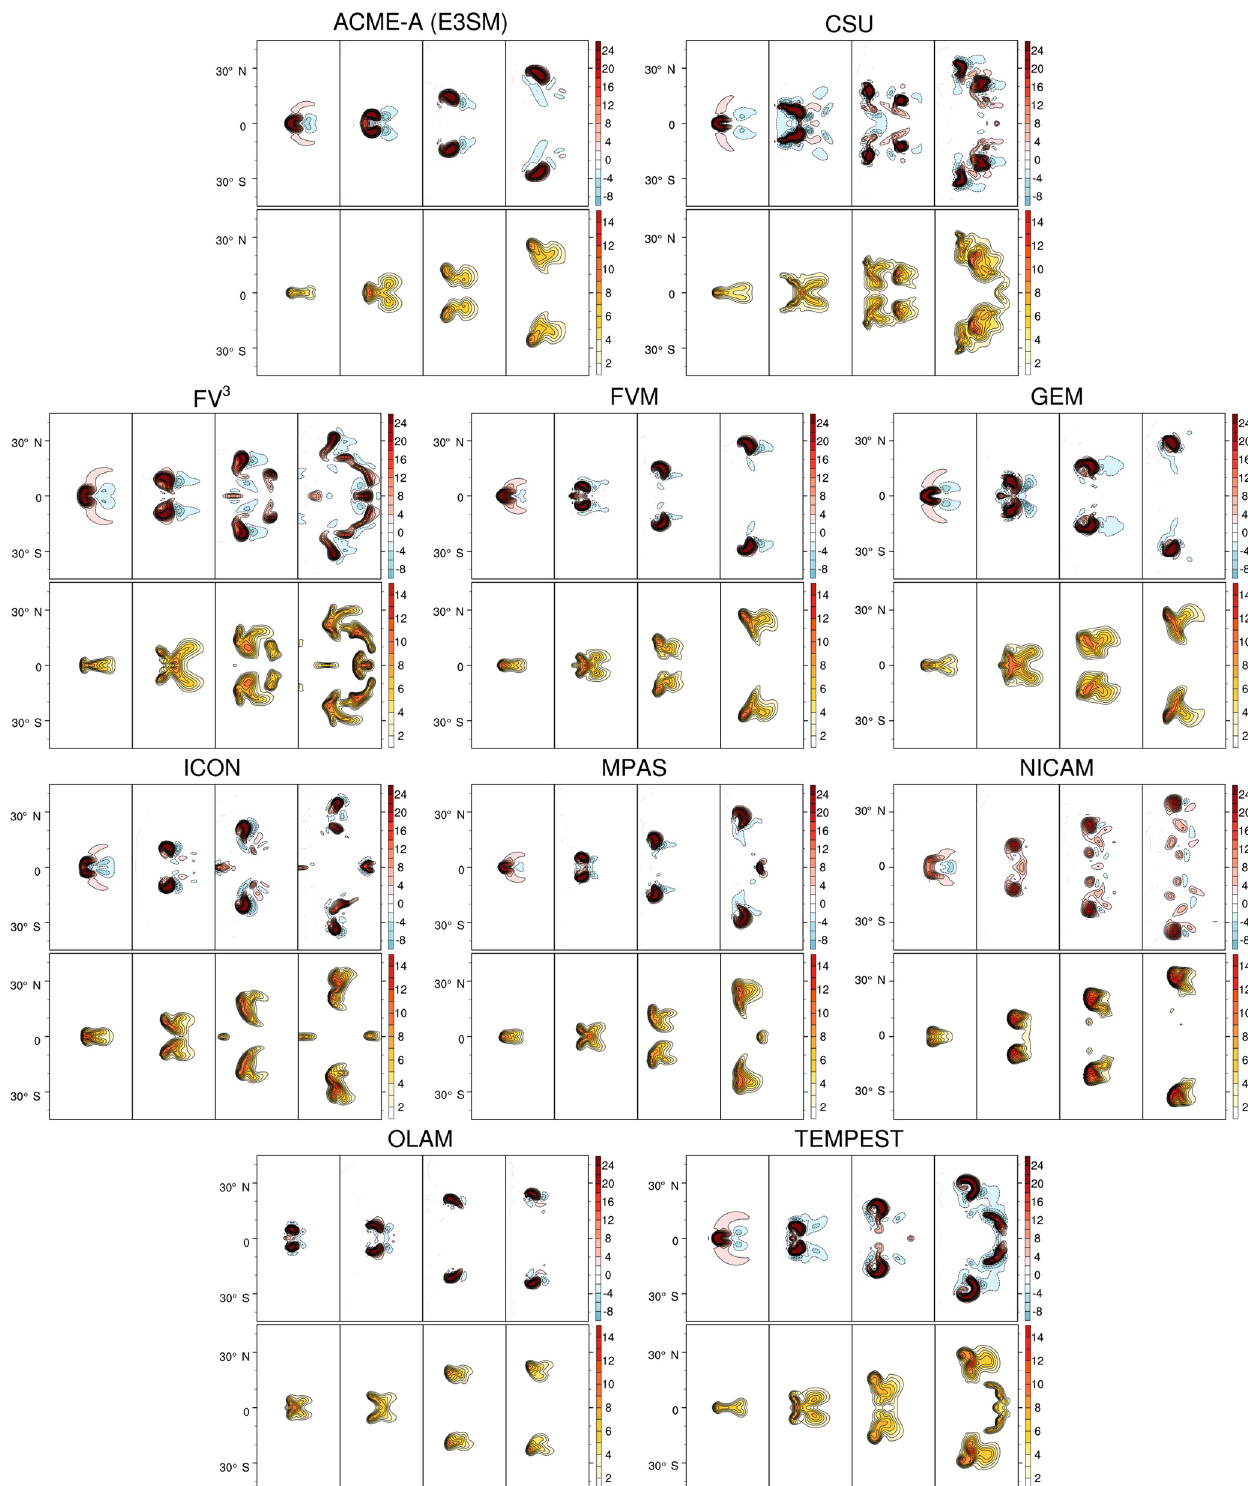
Figure 3. Time evolution of cross-sections of 5km vertical velocity (ms − 1 , top) and 5km rainwater (gkg − 1 , bottom) for each model with the r100 configuration of the test case. From left to right, fields are plotted at 30, 60, 90, and